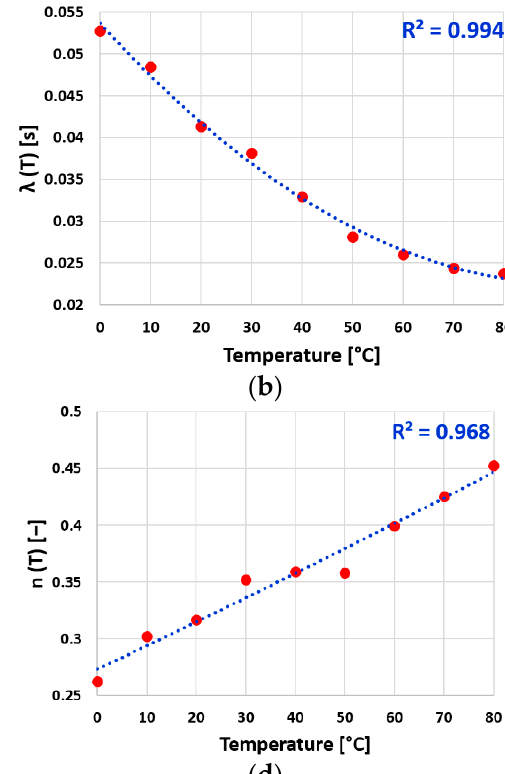
Figure 5. Deduced viscosity data (dots) and viscosity curves (lines) calculated by the fitted model parameter curves. The highest deviation between the deduced and the calculated viscosity data is found to be 34 Pas (relative deviation of 9%), at 80 °C, on 0.676 1/s shear rate; thus, the tempera ‐ ture ‐ dependent viscosity model obtained by parameter estimation is suitable for use in non ‐ Newtonian transient simulation calculated by ANSYS FLUENT commercial software (2019 R1, ANSYS, Canonsburg, Pennsylvania, USA, 2019).